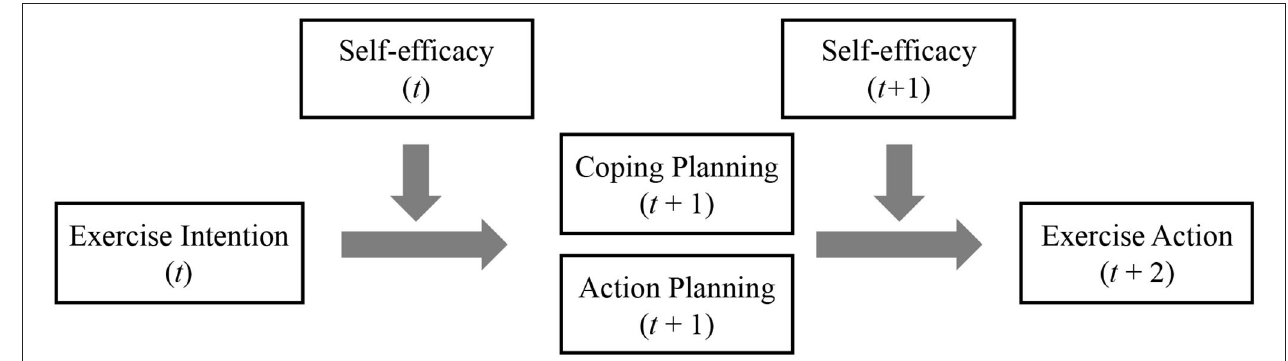
FIGURE 1 | Conceptual model. t , t + 1, and t + 2 indicate that the independent variables were measured at time t , the mediators were measured at lagged time t + 1, and the dependent variable measured at lagged time t + 2.